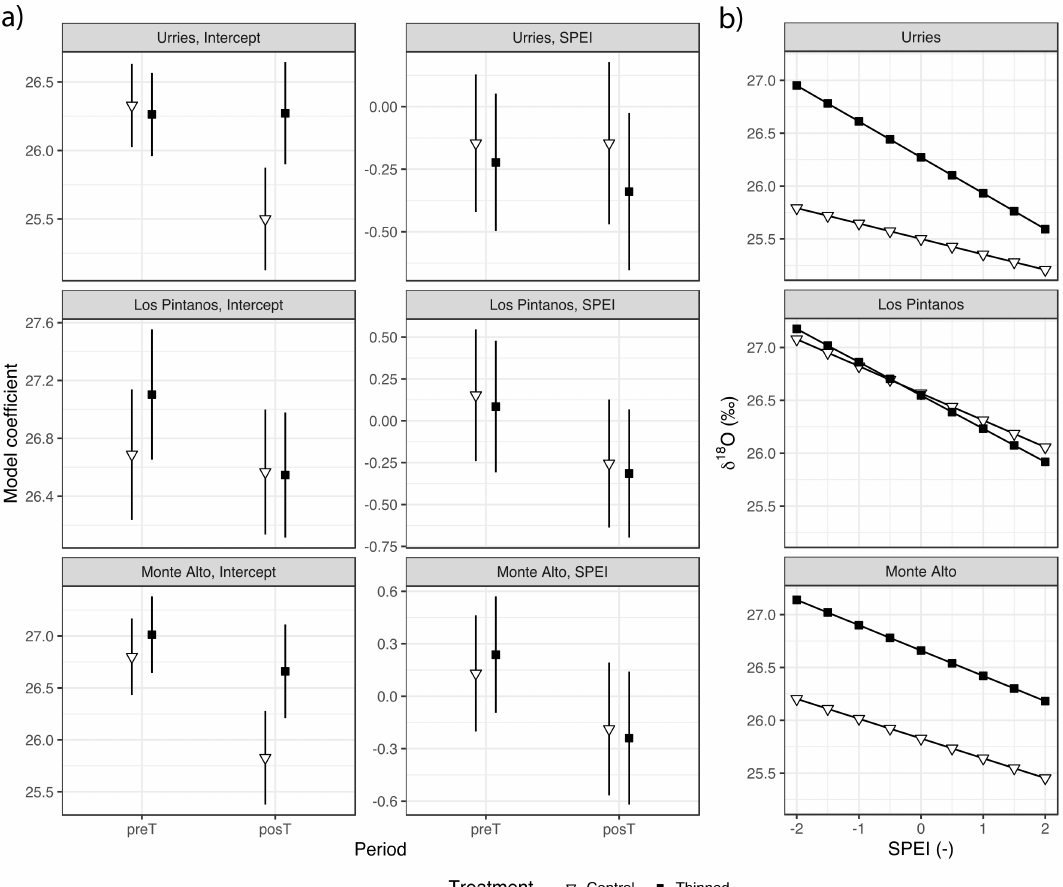
Figure 6. δ 18 O mean model coefficients for the values of the fixed effects (Bars depict 95% confidence intervals) in Urri é s, Los Pintanos and Monte Alto study sites, for the two treatments and pre- ( preT ) and post-thinning ( postT ) periods ( a ), and generalised linear models of δ 18 O versus SPEI for both treatments only in the posT period ( b